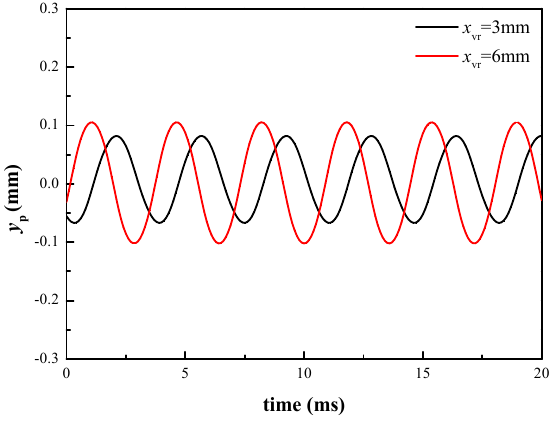
Figure 25. Displacements of different orifice axial lengths.